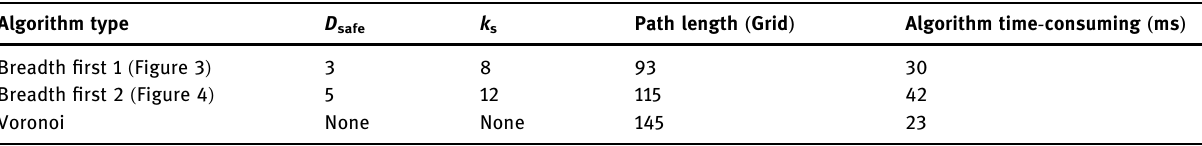
Table 2: Planning performance of the two algorithms Algorithm